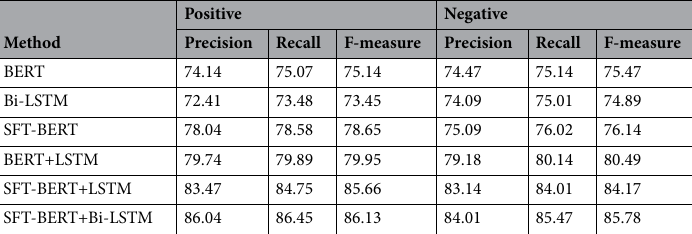
Positive Method Precision Recall F-measure Precision Recall F-measure